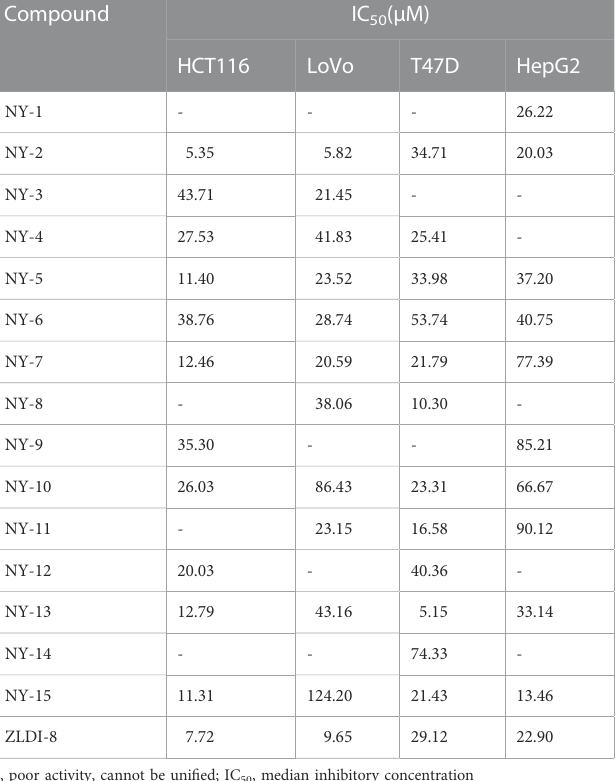
TABLE 1 IC 50 values of ZLDI-8 and its derivatives, NY-1 to -15, in four cancer cell lines.